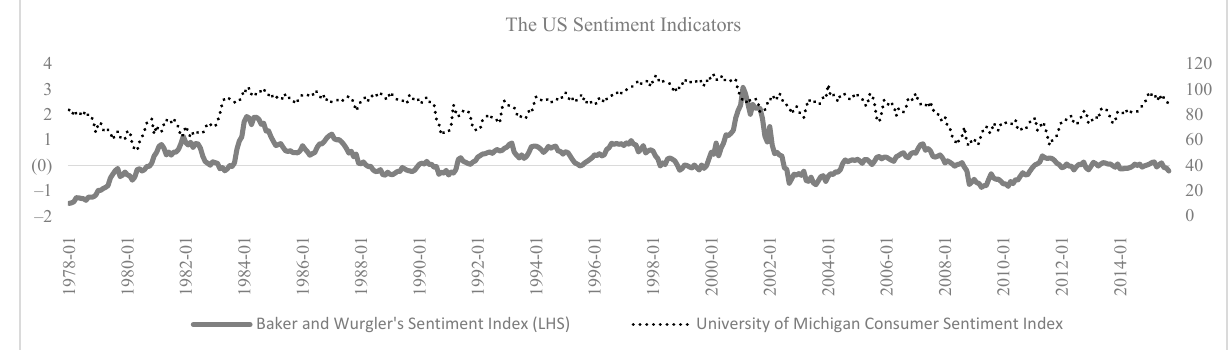
Figure 1. The US sentiment indicators. Note: The figure illustrates the most widely used sentiment indicators: Baker and Wurgler’s sentiment index and University of Michigan consumer sentiment index. Both indices were measured on a monthly basis. Left axis shows values of Baker and Wurgler’s index and right axis shows values of University of Michigan consumer sentiment index. Table 6 provides the constant coe ffi cients (“a” parameter in the regressions, also called “alpha” in common practice) estimated by the regressions suggested by FF3F and FF5F models (Equations (1) and (2), respectively). Alpha refers to excess risk-adjusted return that cannot be explained by the control variables. Any signi fi cant alpha reveals that the relevant anomaly return is not fully explained by the factors suggested by the FF3F or FF5F models and could be potentially explained further by adding other variables to the model. The table shows that, in the case of the US, the coe ffi cient is signi fi cantly positive for anomaly strategies such as momentum, accruals, net share issues and residual variance (investment, operating pro fi tability, market beta and variance) considering both FF3F and FF5F (considering only FF3F). For other regions, investments is the anomaly for which the coe ffi cient is commonly signi fi cant (except Japan) and positive and other anomalies such as size, book-to-market or momentum (in line with Gri ffi n et al. 2003) also reveal signi fi cance. These results indicate that many anomalies are still active (as also documented by Liu et al. 2017) and cannot by fully explained by the FF3F and FF5F models. Table 6. Regression results: constant coe ffi cient (alpha) in the FF3F and FF5F models. US Japan Europe